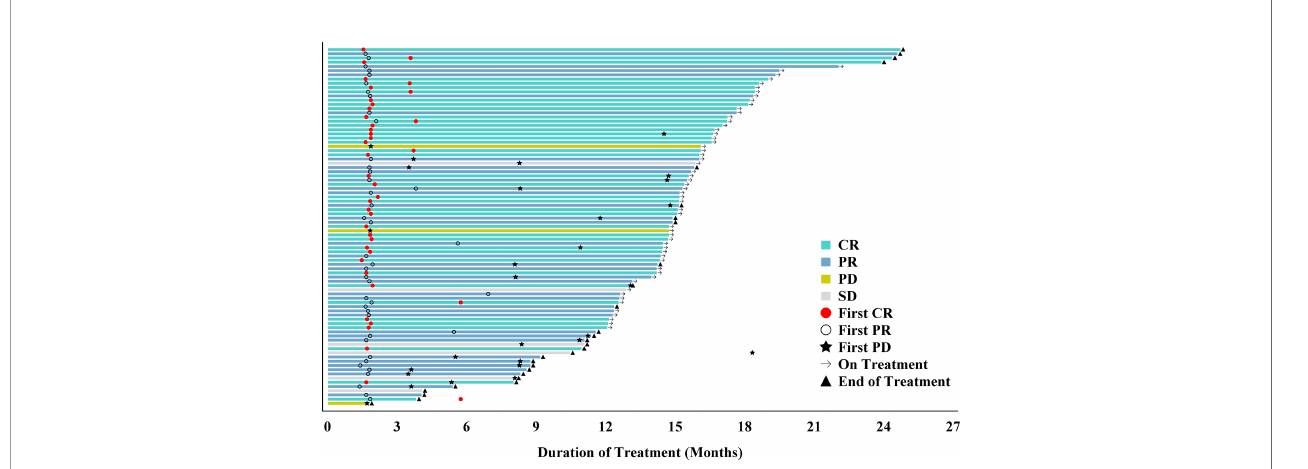
FIGURE 1 | Swimmer plot of time to tumor response (months) of relapsed/refractory classical Hodgkin lymphoma patients receiving penpulimab. Responses were evaluated by the Independent Radiology Review Committee (IRRC) according to the 2014 Lugano classi fi cation. Each bar represents one patient in the full analysis set (FAS). CR, complete response; NA, not applicable; PD, progressive disease; PR, partial response; SD, stable